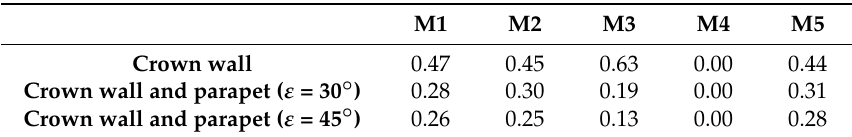
Table 6. The average overtopping discharge at the rear side of the crown wall ( q rear (L/s/m)) for cases without parapet and with parapet ( ε = 30 ◦ and 45 ◦ respectively). M1